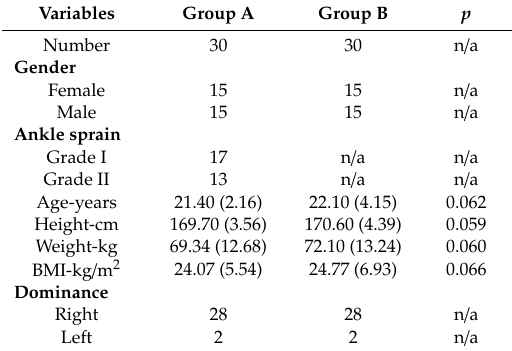
Table 1. Demographic data of the athletes presented as Mean